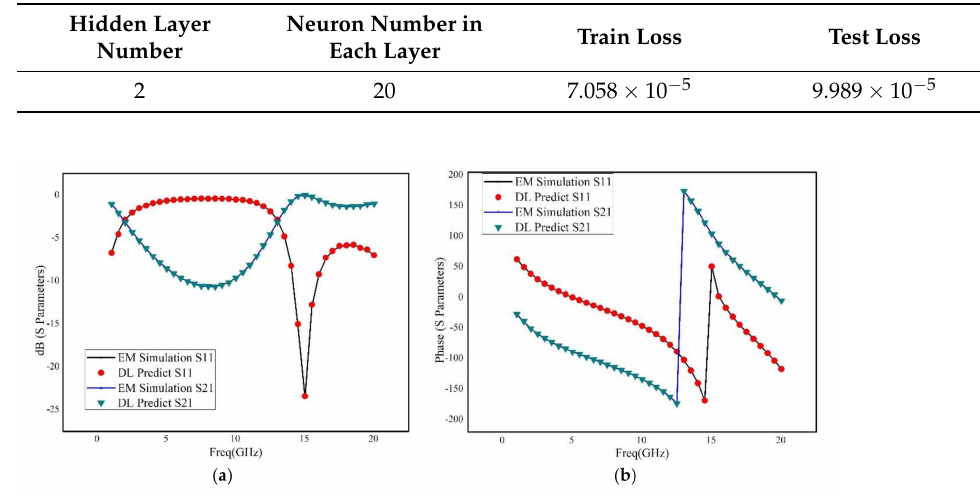
Figure 5. Results of the deep learning versus those from the EM simulation for uniformly sampling. The results of the deep learning are denoted by dots, while the results from the EM simulation are shown by solid lines ( a ) dB of S Parameters. ( b ) Phase of S Parameters.